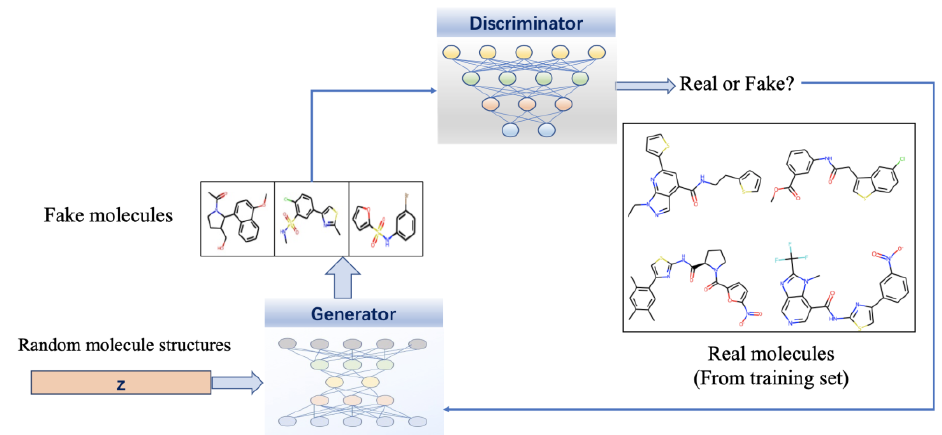
Figure 6. Flowchart of drug design using GANs. It contains a generator and a discriminator, and they are all deep neural networks. The generator transforms latent vectors that are sampled from a prior distribution such as Gaussian into novel molecular data samples, and the discriminator distinguishes fake molecular data generated by the generator from the actual points sampled from the distribution of training data and gives feed-back.